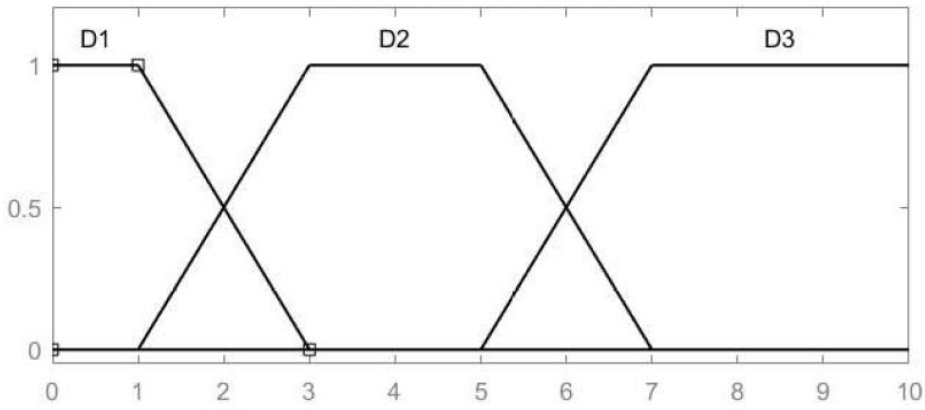
Figure 9. Membership function of